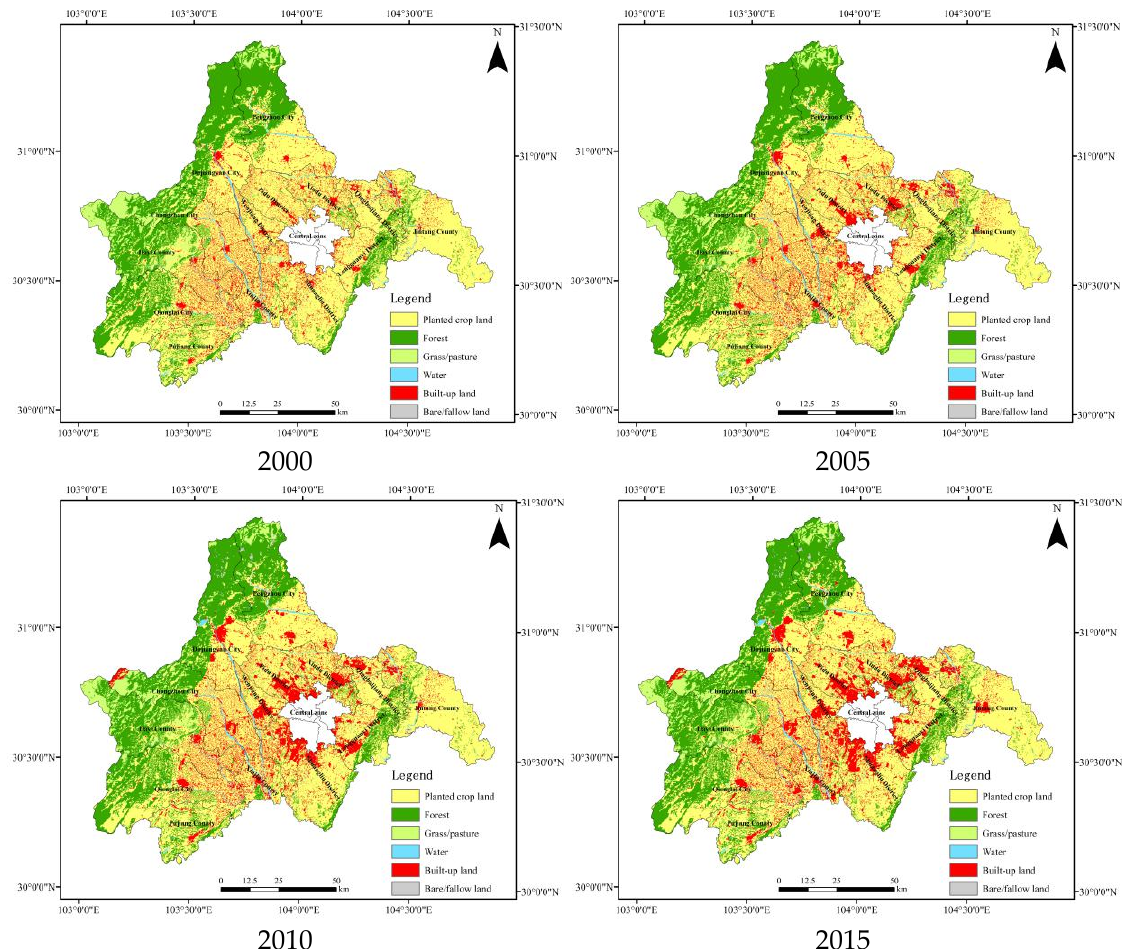
Figure 2. The land-use change of the suburbs and exurbs of Chengdu from 2000 to 2015.